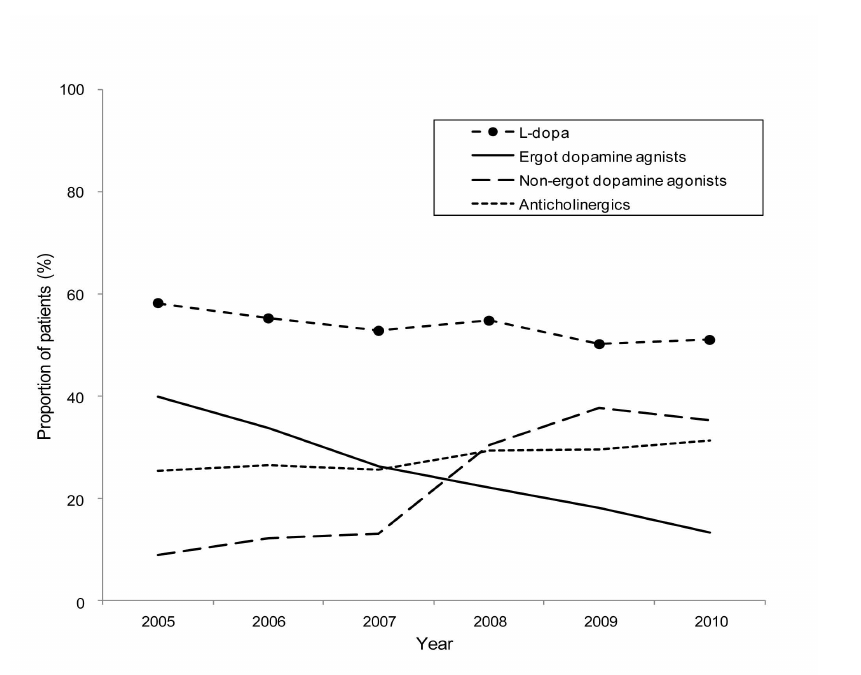
Figure 1. Annual plot for the proportion of Parkinson’s disease patients prescribed each category of anti-Parkinson drugs. Ergot dopamine agonists decreased ( P , 0.001), and non-ergot dopamine agonists increased ( P , 0.001). With respect to L-dopa and anticholinergics, there was no significant change ( P =0.114, P =0.106). Cochran-Armitage trend test was used to calculate P-values (statistical significance level was set at P , 0.002 after Bonferroni